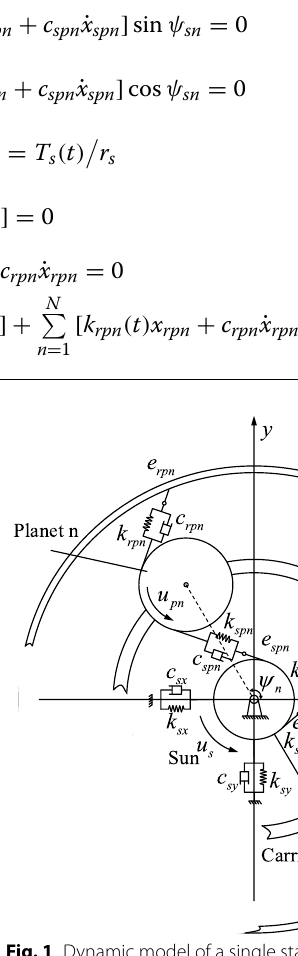
Fig. 1 Dynamic model of a single stage planetary gear